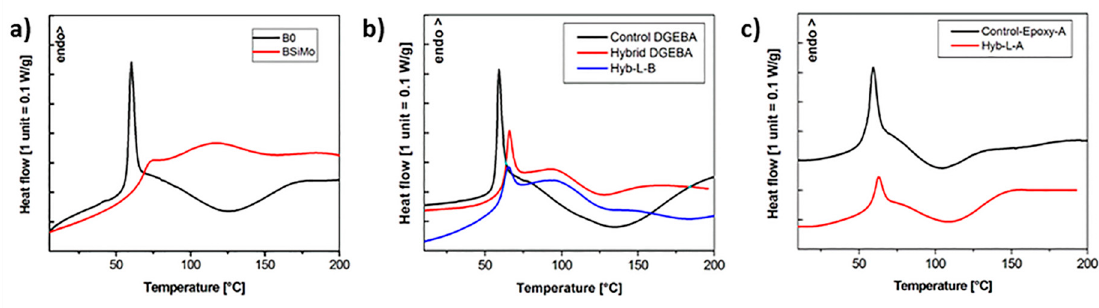
Figure 2. Typical differential scanning calorimetry (DSC) curves found for: ( a ) B0 and BSiMo; ( b ) Control DGEBA, Hybrid DGEBA, Hyb-L-B samples; ( c ) Control Epoxy-A, Hyb-L-A samples. All the systems were cold-cured for prolonged (greater than two months) curing times.